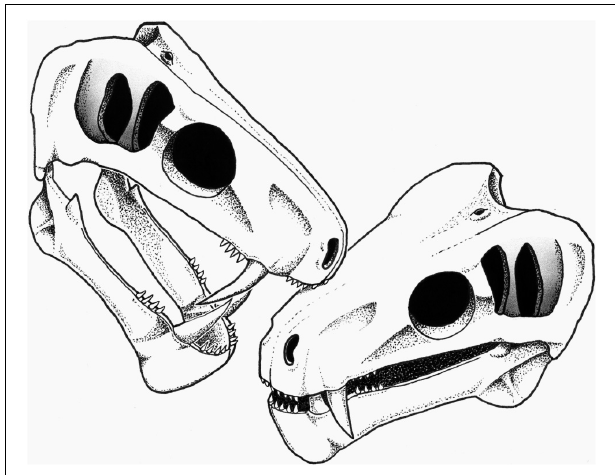
FIGURE 3 | Reconstruction of the biting action by a conspecific leading to the embedded tooth on the snout of SAM-PK-11490 (see section “Discussion”). Artist: S.